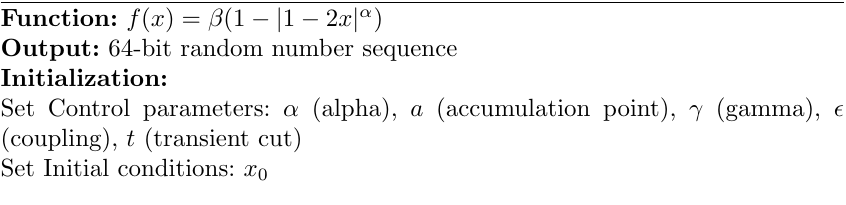
Algorithm 1 Generate a 64-bit pseudo-random sequence using CML system with GSM mapping and adaptive β